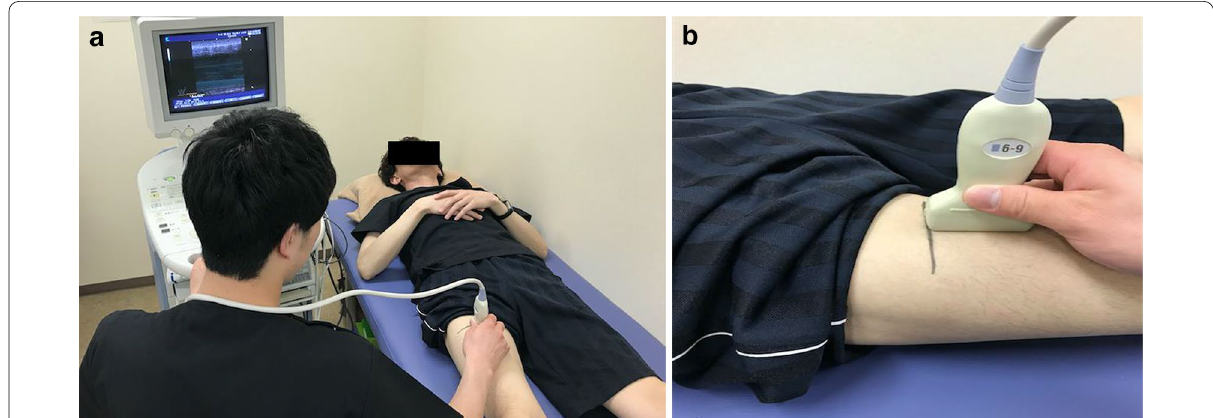
Fig. 1 Ultrasonography set-up in the measurement of skeletal muscle thickness. a Participant is depicted in a supine position while the user holds the ultrasound probe against the anterior surface of the thigh. b The exact position of the probe is illustrated. Muscle thickness was determined from the resulting ultrasound images, and the values from two independent raters were used to decipher the intra- and inter-rater